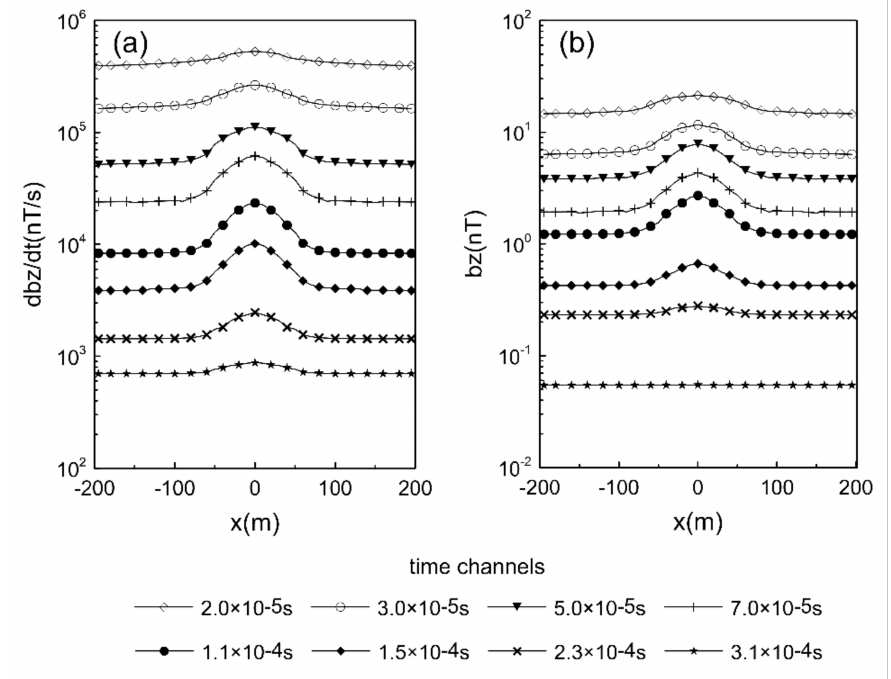
Figure 5. ( a ) dbz/dt and ( b ) bz responses for the horizontal plate model in Figure